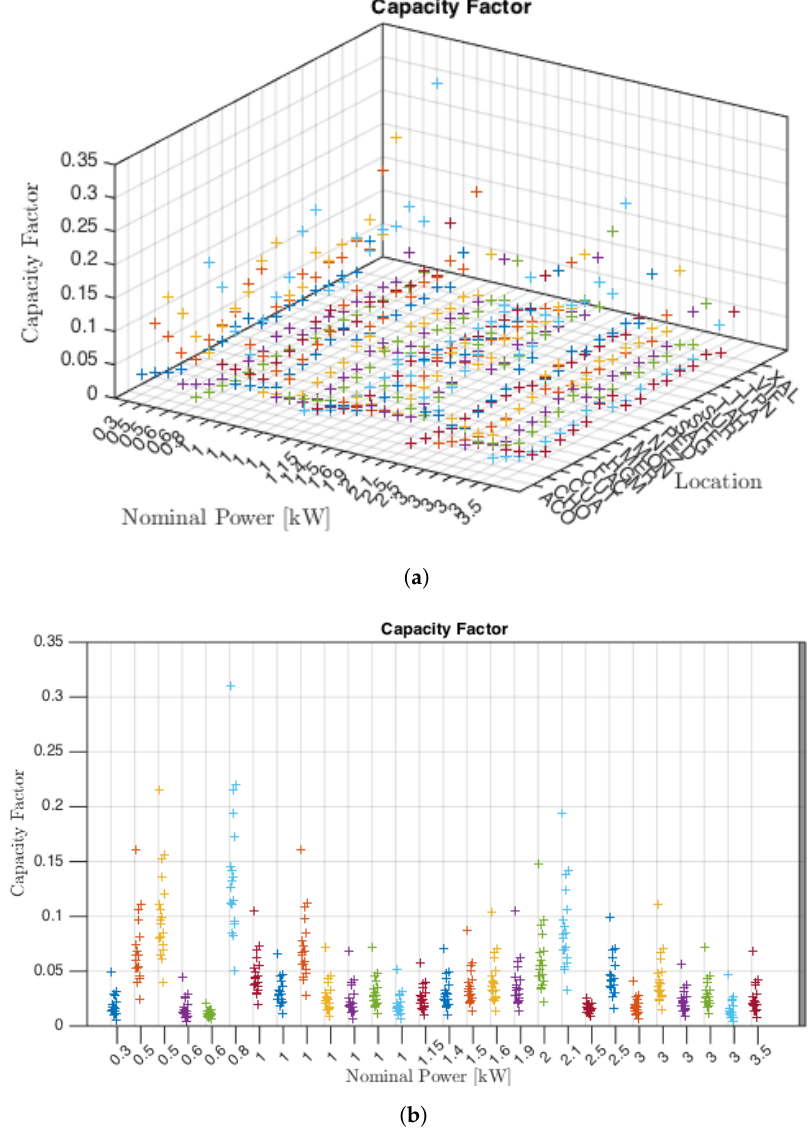
Figure 13. CF values are calculated for each site and all 28 SWT s. It is observed that, for a specific SWT , wind speed conditions are similar within Mexico Valley due to the similar CF values in all locations. Although similar wind conditions exist, power production is defined by the characteristics of the technology represented by the power curve. ( a ) The capacity factors (CFs) were calculated for each location studied. The nominal power and location axes preserve the same order as that presented in Figure 10a; ( b ) In order to observe the dependence of CF at particular locations, the corresponding axis was